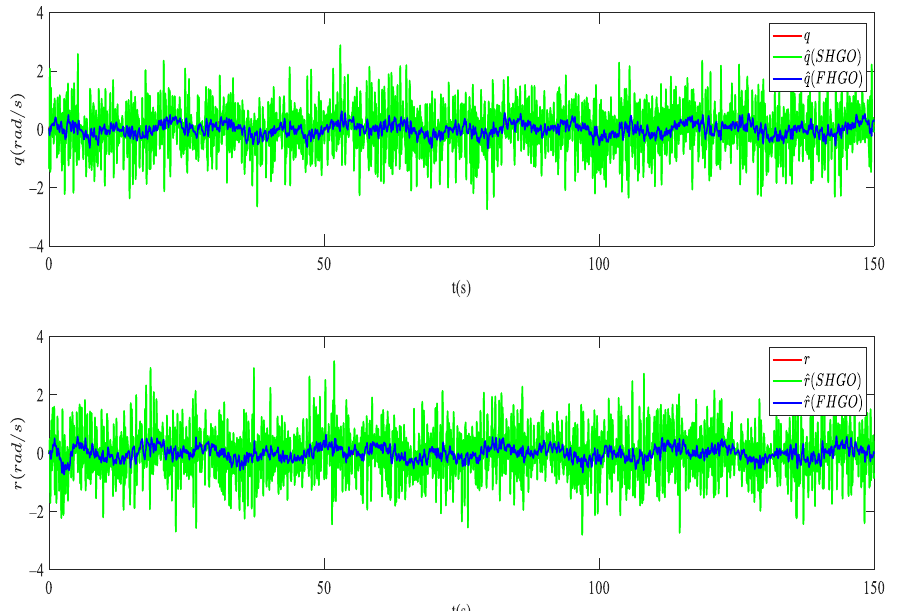
Figure 5. Angle velocity state estimation of state observer.